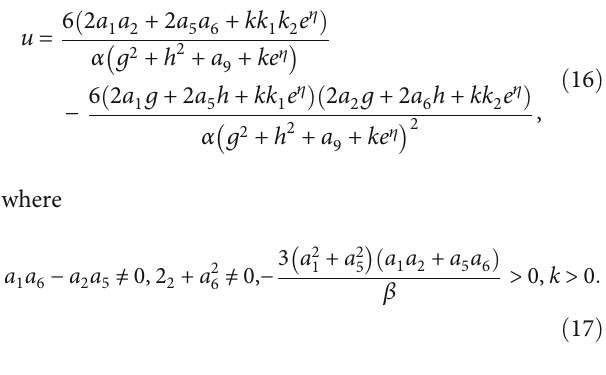
= a = α = − β = γ = 1 , a 1 5